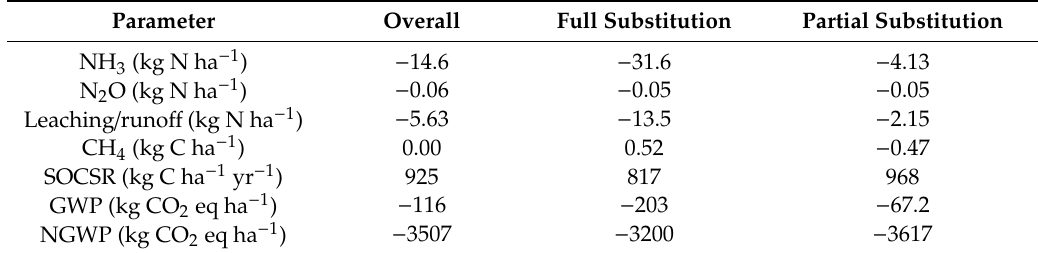
Table 1. Net global warming potential parameter values according to organic fertilizer substitution amount. Parameter Overall Full Substitution Partial Substitution NH 3 (kg N ha − 1 ) − 14.6 − 31.6 − 4.13 N 2 O (kg N ha − 1 ) − 0.06 − 0.05 − 0.05 Leaching / runo ff (kg N ha − 1 ) − 5.63 − 13.5 − 2.15 CH 4 (kg C ha − 1 ) 0.00 0.52 −